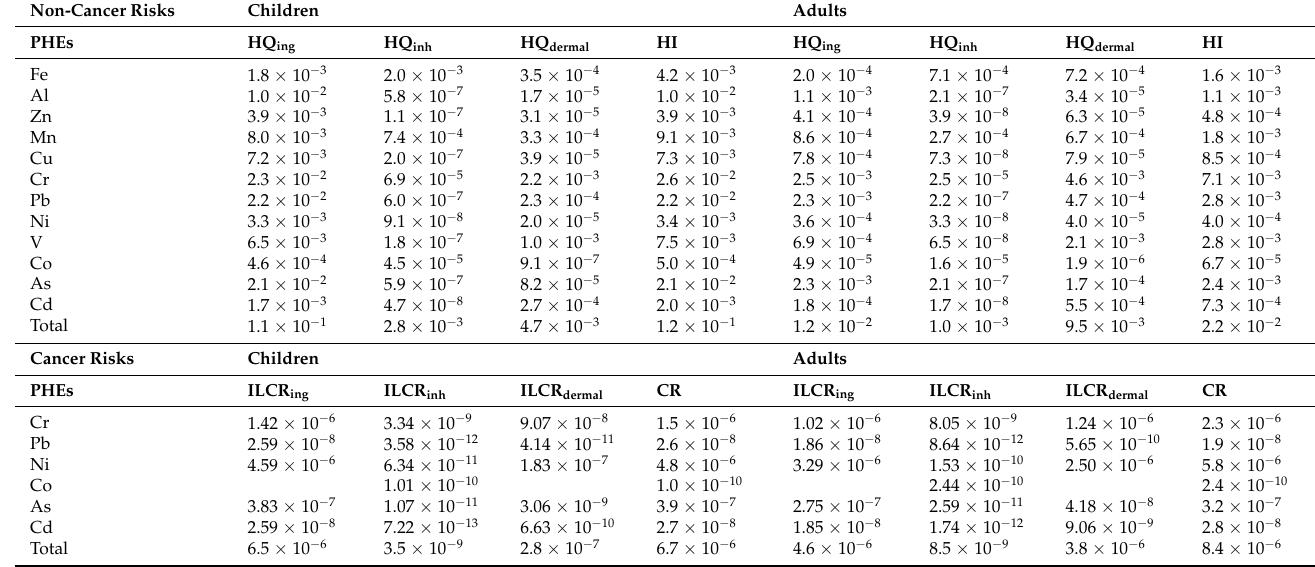
Table 4. Summary of hazard quotients (HQ), hazard index (HI), incremental lifetime cancer risk (ILCR), and cancer risk (CR) of PHEs in ACFD collected samples from Dammam metropolitan mosques via non-dietary ingestion, inhalation, and dermal contact exposure